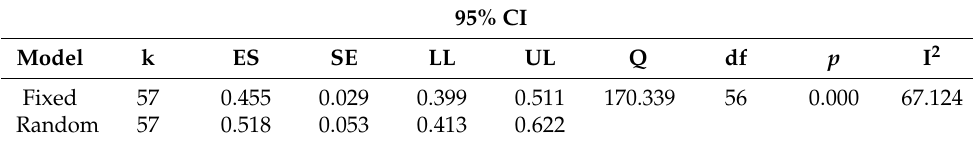
Table 2. Meta-analysis results—overall effect sizes and heterogeneity.